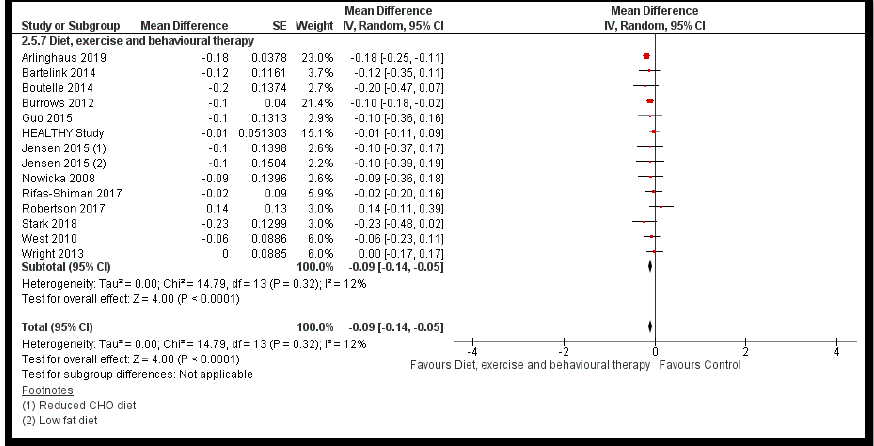
Figure 13. Forest plot for the effect of diet, exercise and behavioural therapy interventions for obesity management on body mass index (BMI) z -score .